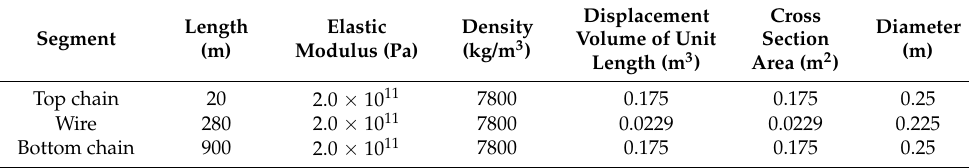
Table 3. Main parameters of mooring lines.